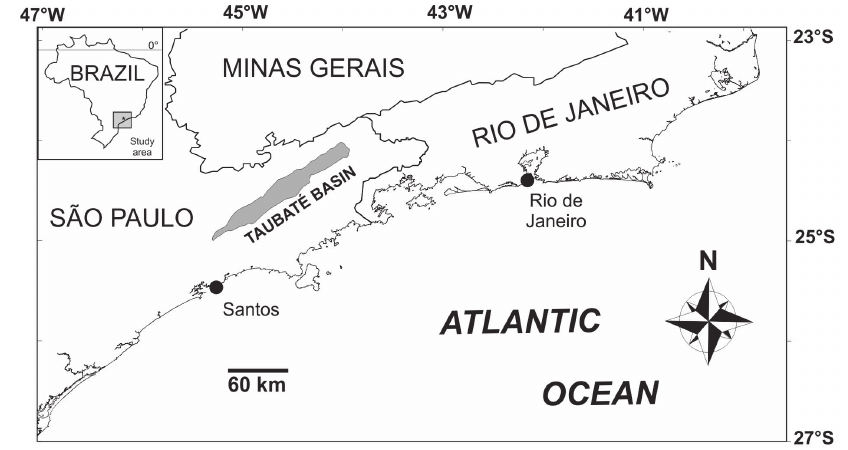
Figure 1 - Map of location of the Taubaté